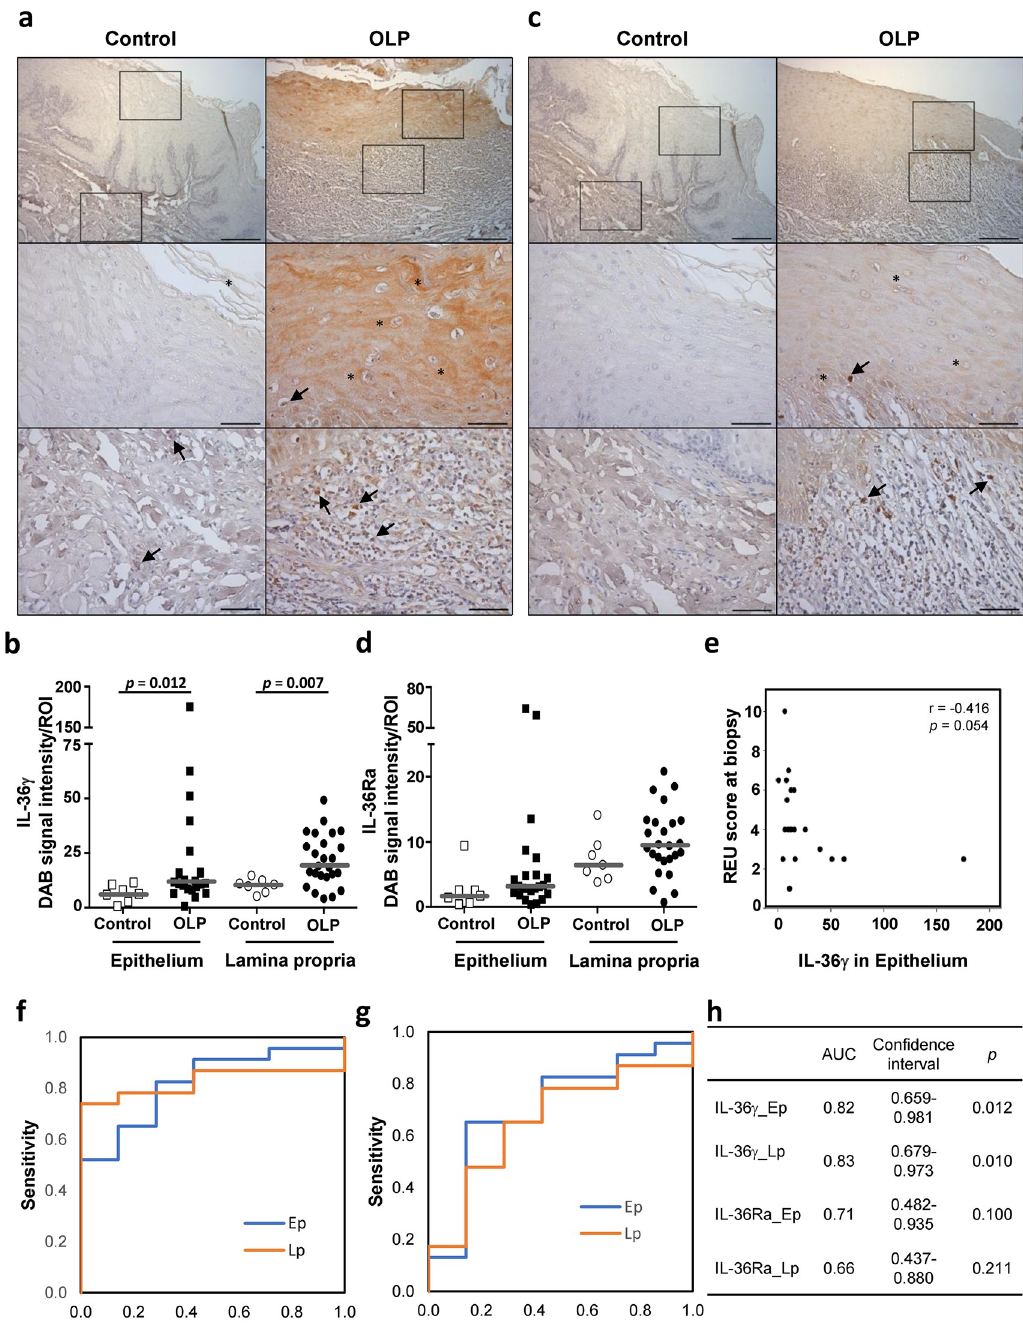
Fig 3. Immunohistochemical detection of IL-36 γ and IL-36Ra in OLP versus control tissue sections. Sections of OLP (n = 25) and control (n = 7) tissues were subjected to immunohistochemical detection of IL-36 γ (a) and IL-36Ra (c), and the signal intensities in the epithelium and mucosa were measured by ImageJ (b, d). Asterisks and arrows depict IL-36 γ expression in epithelial cells and immune cells, respectively. The expression levels in the presented images are equivalent to the median value of each group (low magnification x100, scale bar = 200 μ m; high magnification x400, scale bar = 50 μ m). (e) Correlation plot between the levels of IL-36 γ expression in the epithelium and clinical severity scores. (f, g) Receiver operating characteristic (ROC) curves of IL-36 γ (f) and IL-36Ra (g) expressions in the epithelium (Ep) and lamina propria (Lp). (h) The area under curve (AUC) and significance of ROC curves shown in f and g.